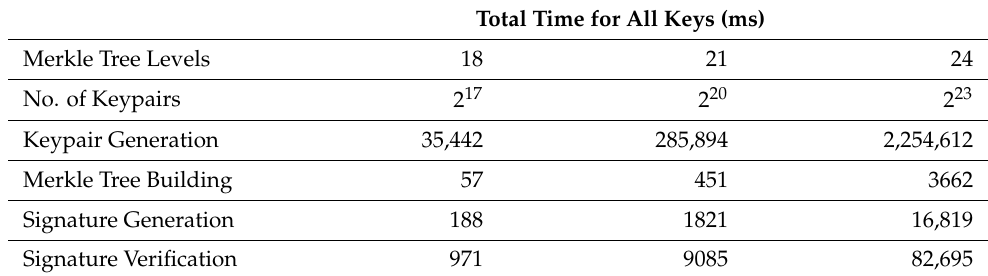
Table 1. Total time required to run an individual algorithm in the protocol.